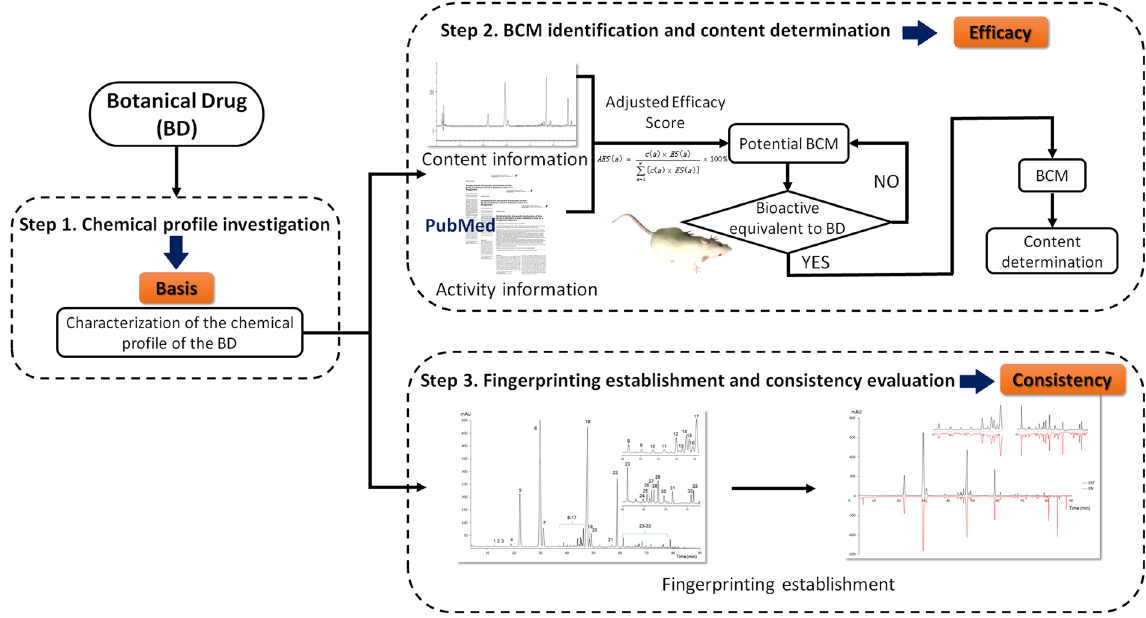
Figure 1. The flowchart of the bioactive chemical markers based quality assessment strategy for botanical